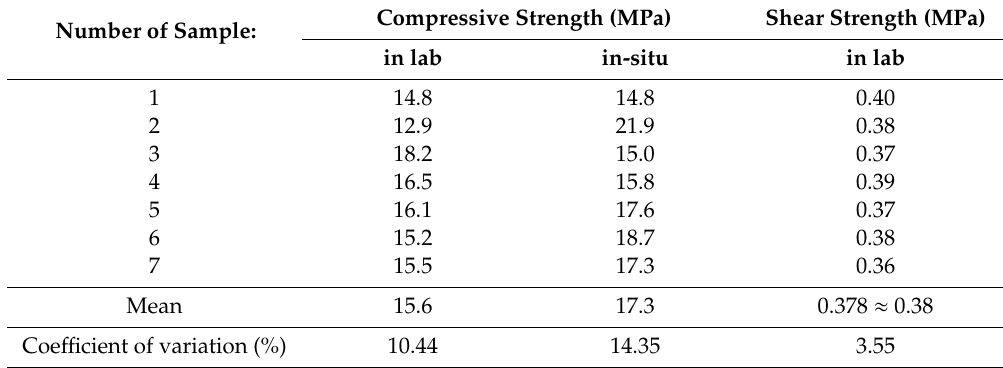
Table 2. Compressive and shear strength of the brick wall part derived from the viaduct